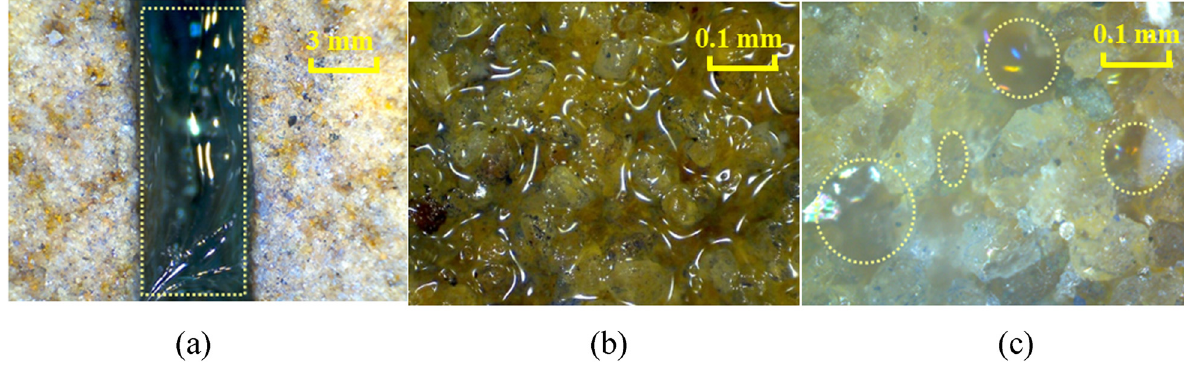
Figure 4: Occurrence states of polymer gel in the fracture and matrix after gelling. ( a ) Gel clusters, ( b ) gel layer, ( c ) dispersed